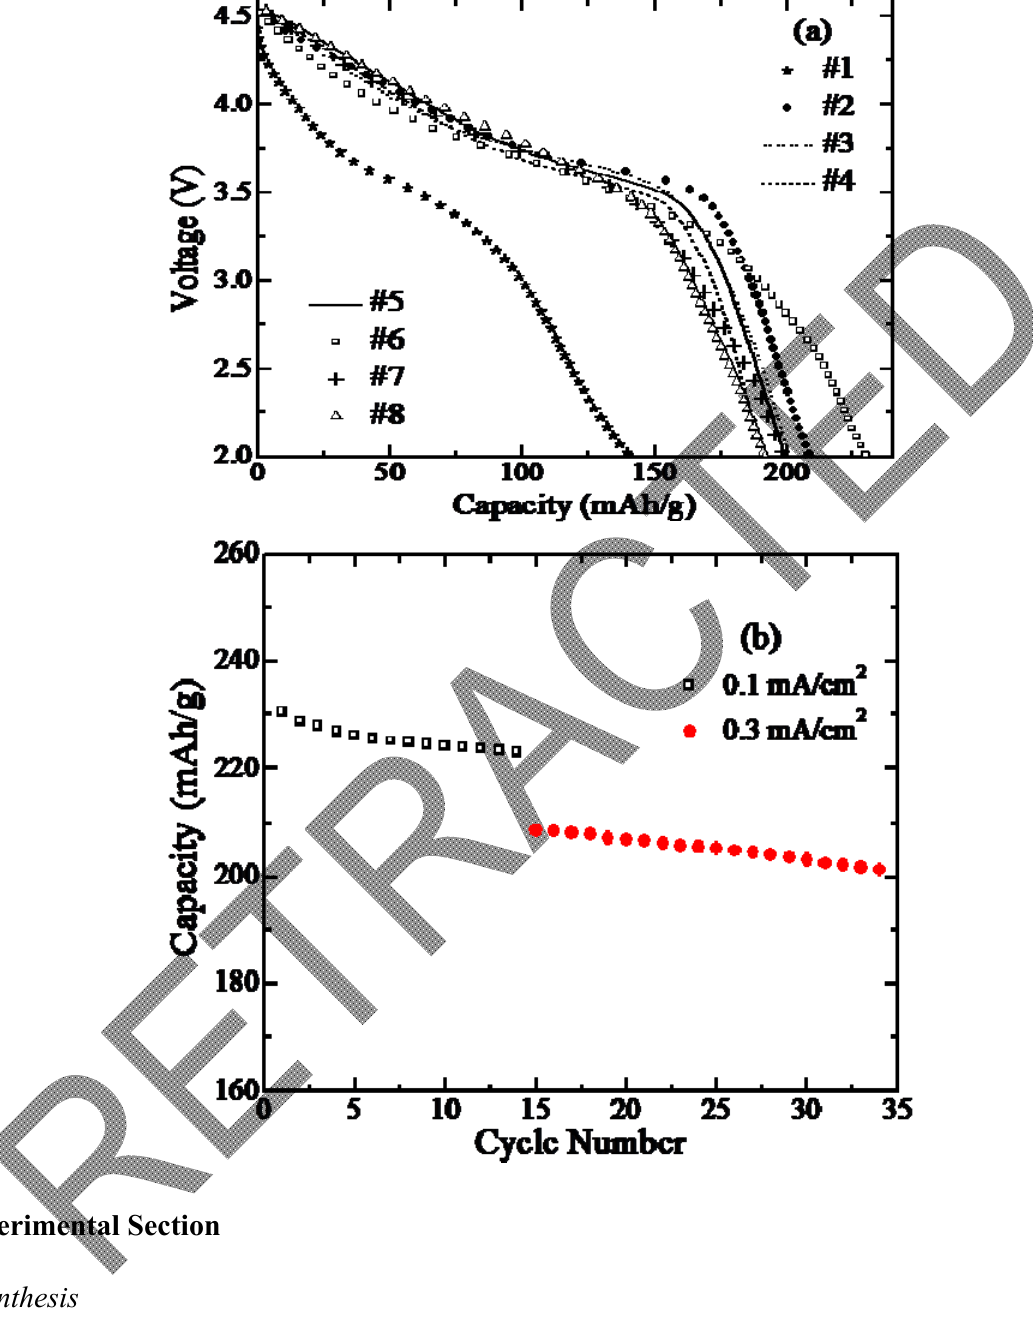
Figure 9. (a) Discharge voltage profiles of all the compositions. (b) preliminary extended life-cycle testing of the